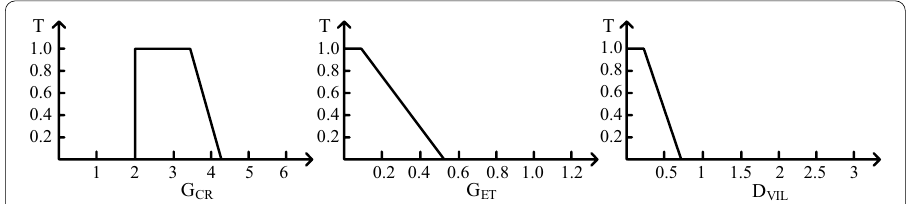
Fig. 11 The trapmf membership functions corresponding to the stratiform